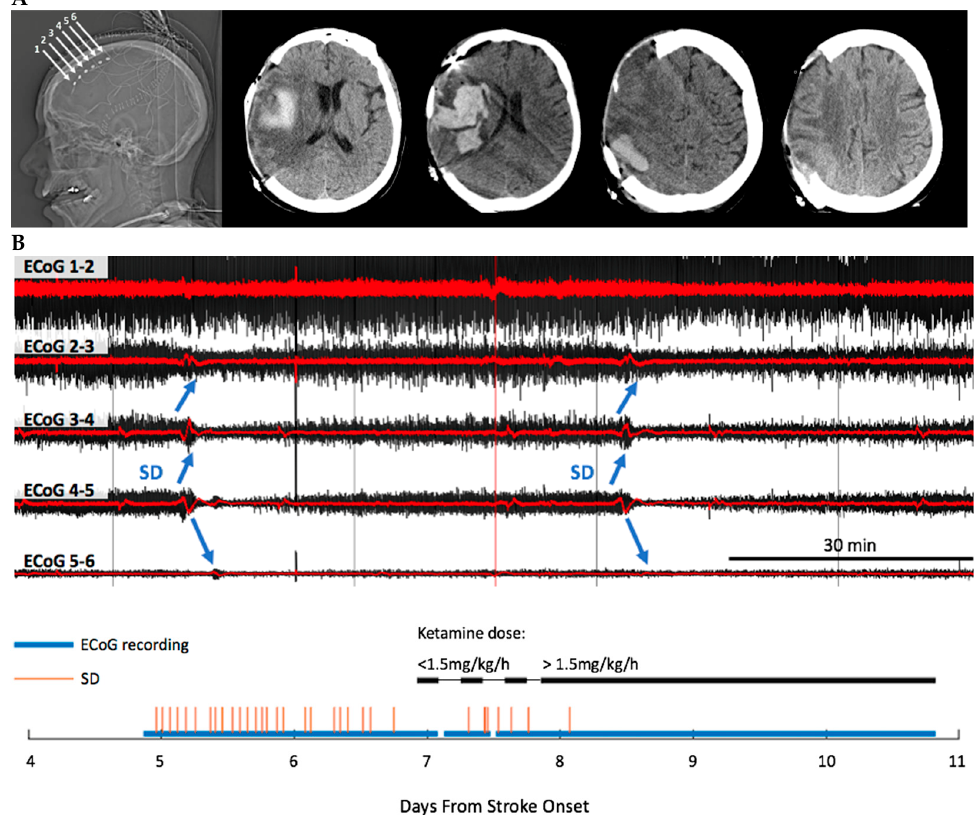
Figure 2. ( A ) MCA stroke with hemorrhagic conversion in subject 4. The electrode strip was placed in peri-infarct tissue radiating outward from ischemic region, such that electrodes 1 to 2 (corresponding to ECoG channel 1–2 in ( B )) were located in the most normally perfused tissue, furthest from the infarct core, while electrodes 5 to 6 (corresponding to ECoG channel 5–6 in ( B )) were located in the most hypo-perfused tissue, just bordering the infarct core. ( B ) A representative SD propagating across electrodes on the strip. A sequential bipolar montage of the five ECoG channels acquired from the electrode strip is depicted. The raw ECoG of a slow potential change spreading from ECoG channel 1–2 through sequential channels to ECoG channel 5–6 (shown in red) is associated with depression of ECoG activity (high-pass filtered ECoG (>0.5 Hz), shown in black). Bottom panel shows the total SDs observed during monitoring. Ketamine was initiated to treat intractable SDs associated with clinical decline. Only one SD occurred after ketamine dose was adjusted to therapeutic dose.